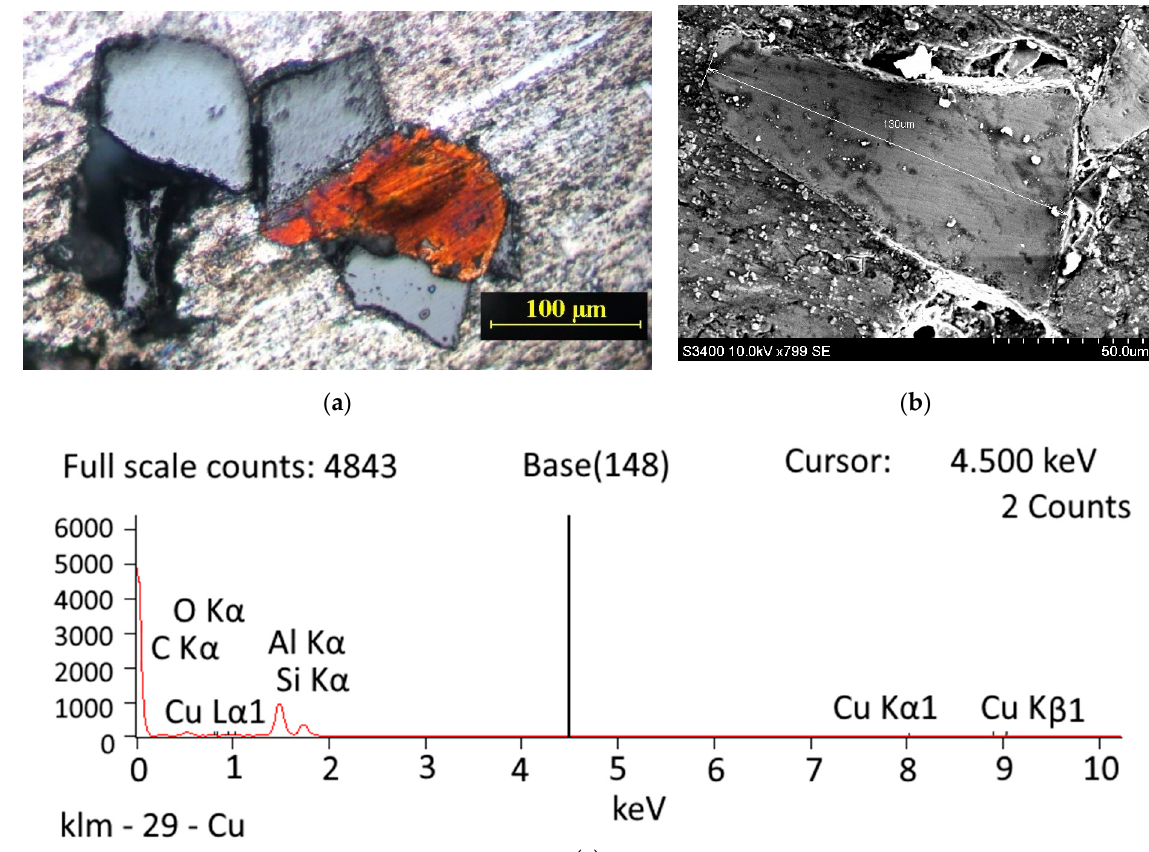
Figure 3. Presence of copper on the surface of the SiC particle observed. ( a ) By optical microscope, ( b ) by SEM analysis, ( c ) by EDS. Table 3. Results of EDS analysis on the studied material.